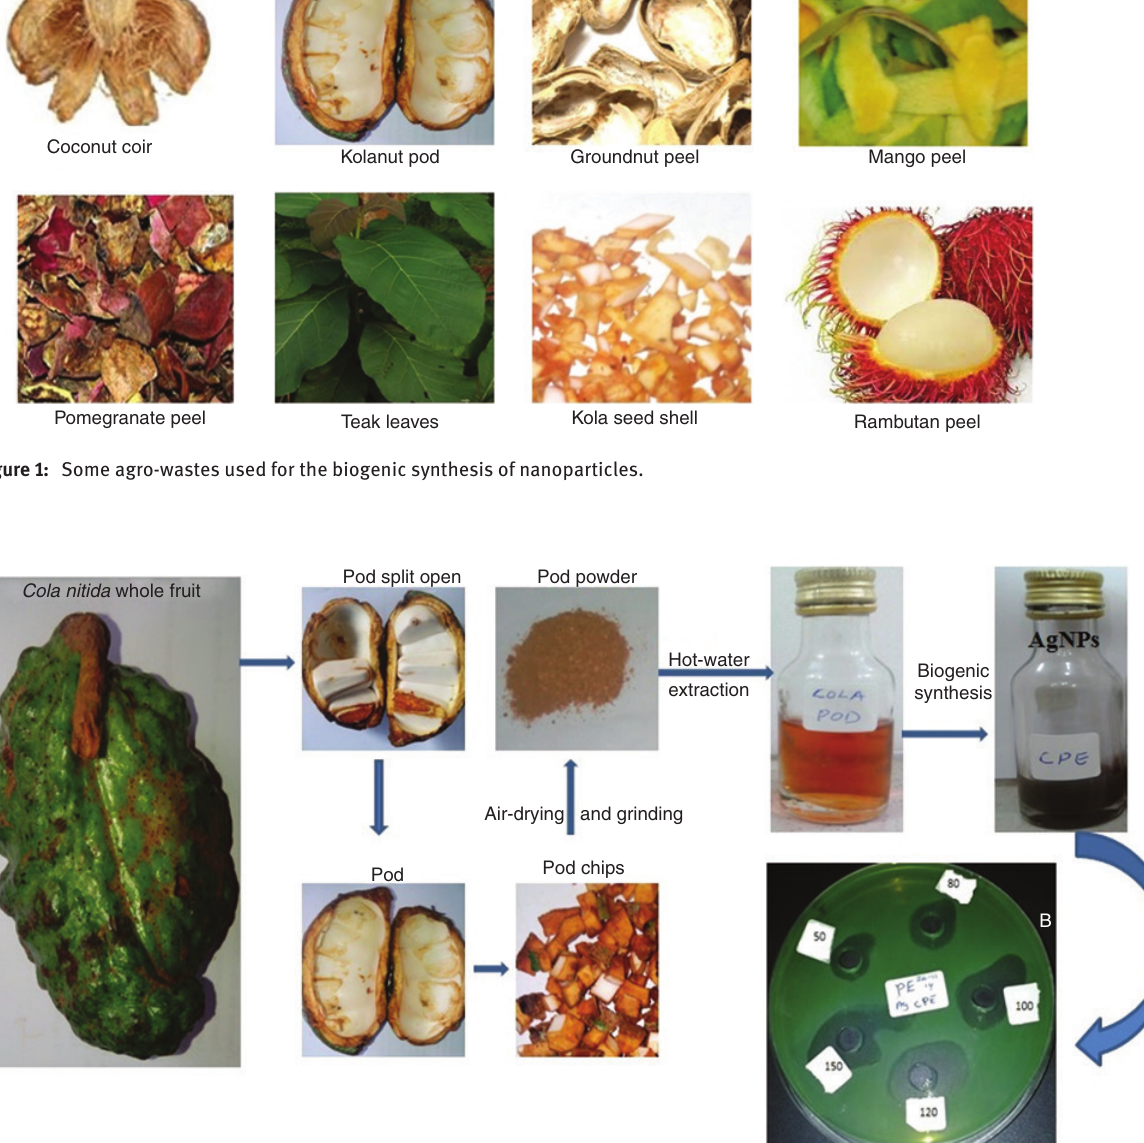
Figure 2: Schematic view of processing of kola nut pod for the biosynthesis of AgNPs with profound antibacterial activity.